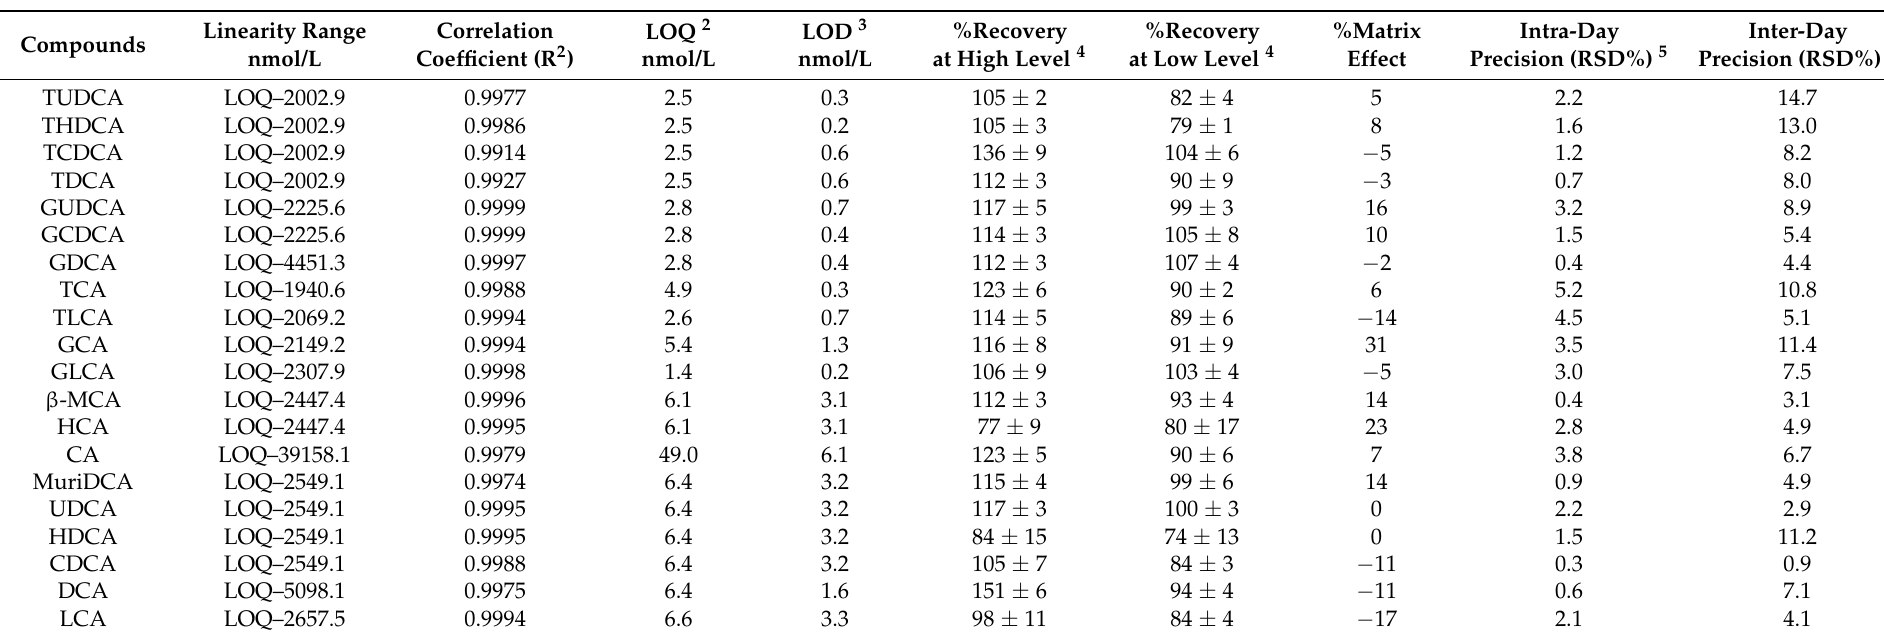
Table 2. Linearity range, LOQ, LOD, recovery, matrix effect, and precision of bile acids in plasma—UHPLC-QQQ method validation 1